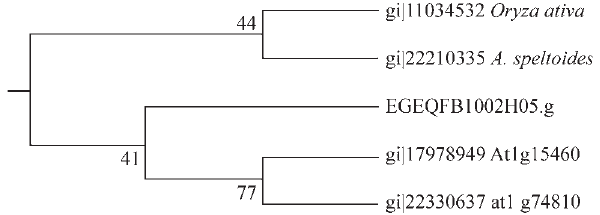
Figure 3 - Subtree detailing the relationship between contig EGEQFB 1002H05.g and hypothetical proteins of Arabidopsis thaliana . Bootstrap values were shown in percentages. Sequences were represented with their access in GenBank (GI) and the relevant species.